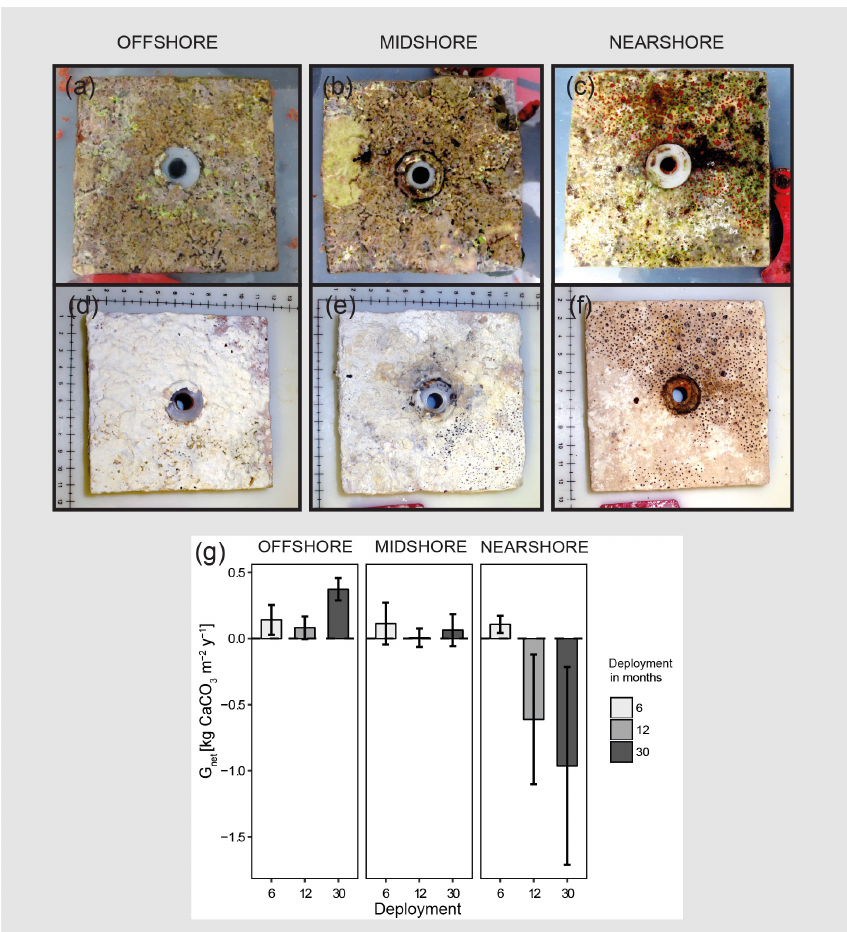
Figure 2. Net-accretion/-erosion rates ( G net ) in the central Red Sea. G net were measured in situ using limestone blocks (100 × 100mm) that were deployed along the cross-shelf gradient; three sets of four blocks were deployed for 6, 12, or 30 months in each reef site, respectively. Photos (a) , (b) , and (c) show freshly collected limestone blocks that were recovered after 30 months of deployment. The photos (d) , (e) , and (f) show the same blocks after bleaching and drying. Boring holes of endolithic sponges are clearly visible in blocks from the nearshore and midshore reef sites. Blocks from the midshore and offshore reefs are covered with crusts of biogenic carbonate mostly accreted by coralline algae assemblages (scales in the photos show centimeters). G net data obtained from the limestone block assay are plotted in (g) . All data are presented as means ± standard